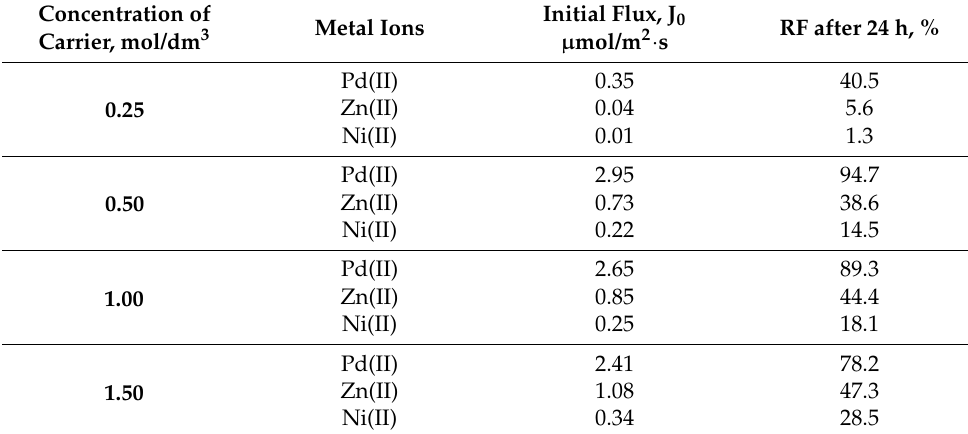
Table 5. The initial fluxes for competitive transport of Pd(II), Zn(II) and Ni(II) ions across PIMs doped with 1-pentyl-1,2,4-triazole ( 1 ) and recovery factor after 24 h; membrane: 2.6 cm 3 o -NPPE/1 g